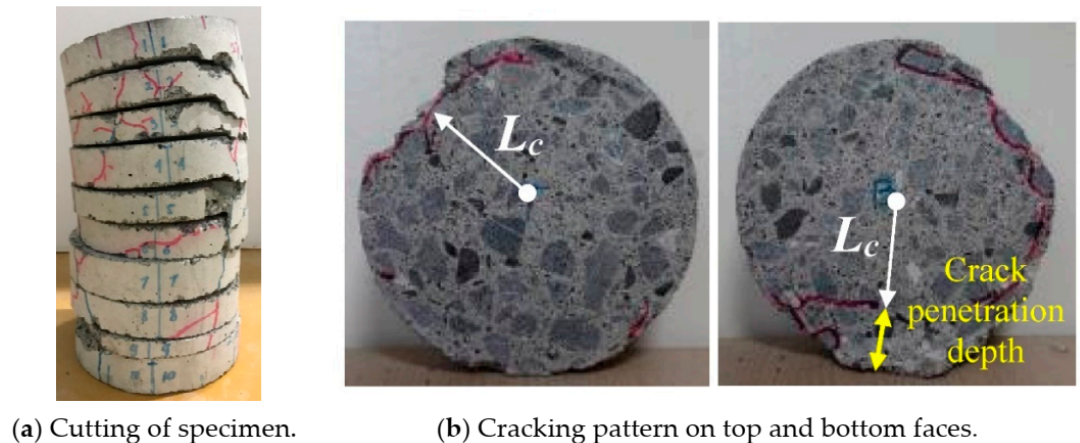
Figure 4. Measuring of crack penetration depth.